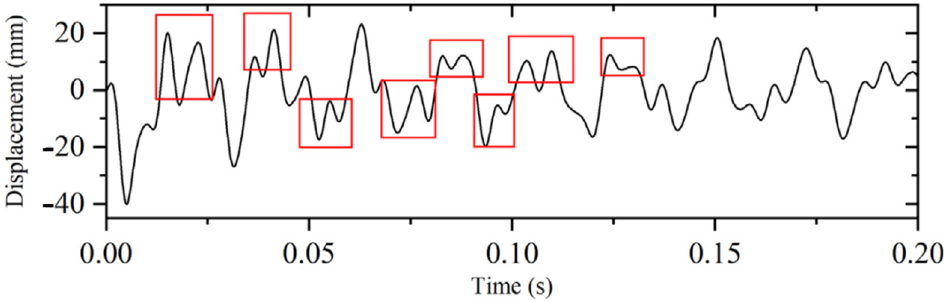
Figure 13. Time course curve of tensioned membrane displacement affected by impact loading [82].